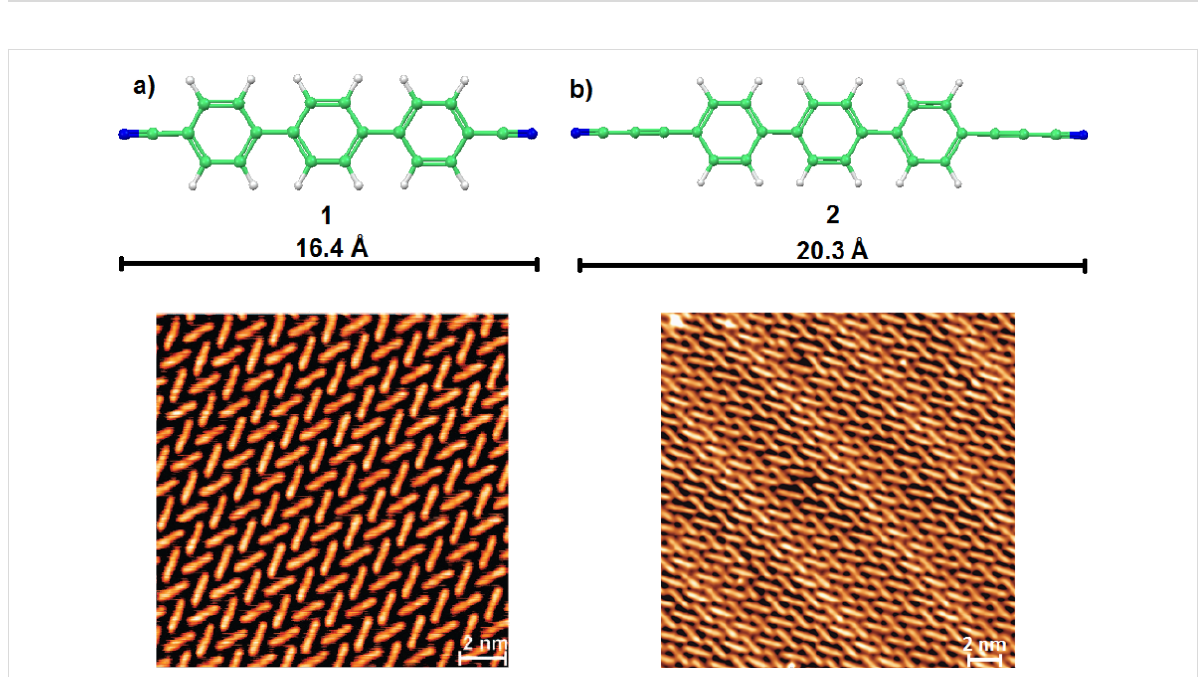
Figure 3: Comparison of the molecular self-assembled monolayers of 1 and 2 on a Ag(111) surface. a) Densely packed chevron layer formed by NC–Ph 3 –CN ( 1 ), adapted from [43]; b) Densely packed chevron layer formed by the NC–C ≡ C–Ph 3 –C ≡ C–CN ( 2 ) species (data measured at 6 K; image size: 239 × 239 Å 2 ; scanning parameters: V bias = 0.3 V, I = 0.05 nA).